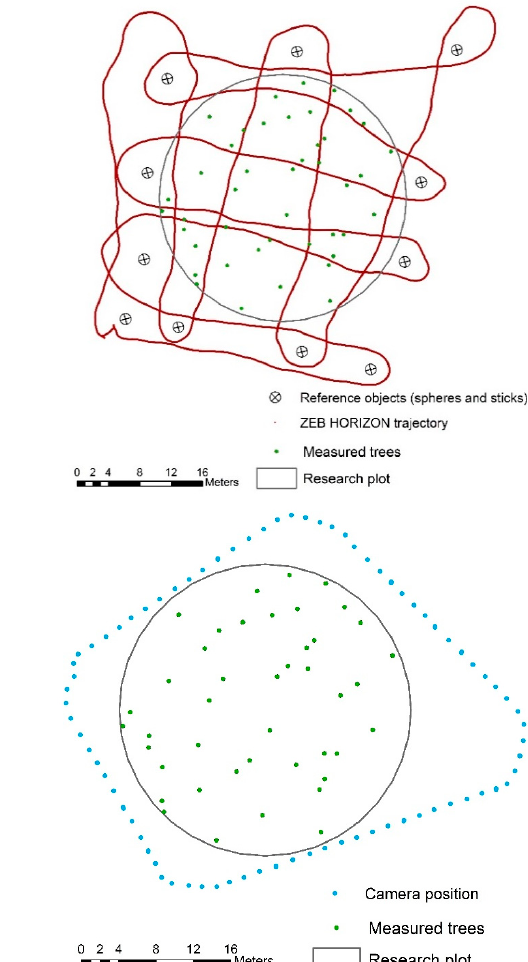
Figure 2. Scanning schemes of the research plot with a 16 m radius: ( A ) terrestrial laser scanning (TLS); ( B ) handheld mobile laser scanning (HMLS); and, ( C ) close-range photogrammetry (CRP).